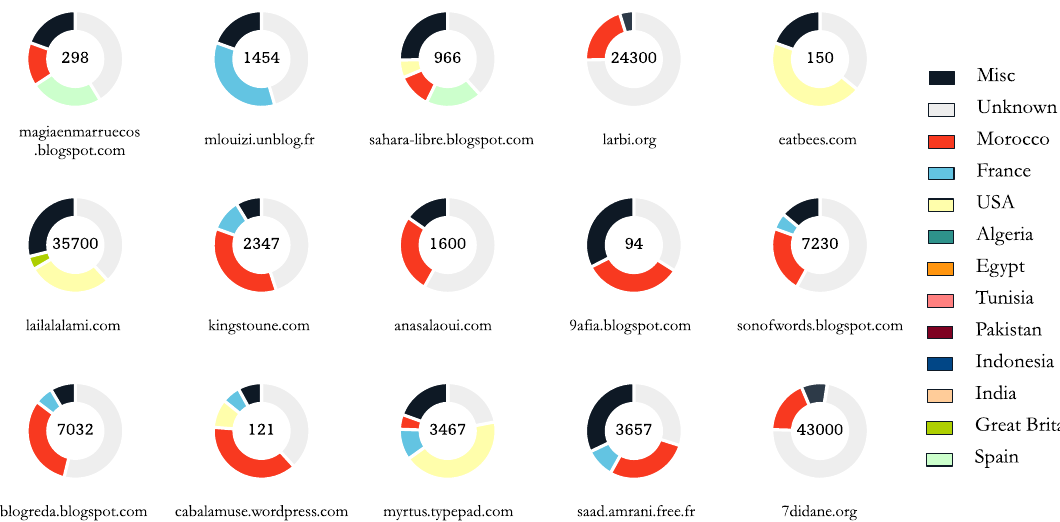
Fig. 5 Preserving a diasporic aspect. The geographical distribution of the blogosphere ’ s followers on Twitter